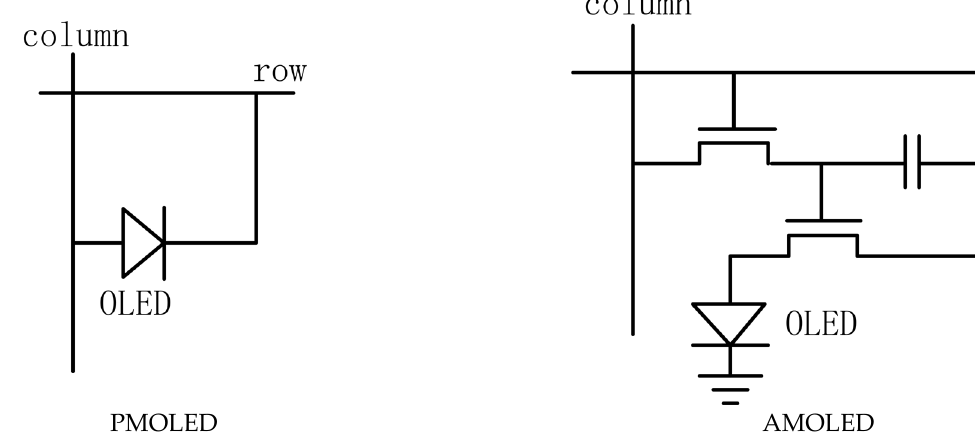
Figure 1. Schematic of PMOLED and AMOLED [4] .